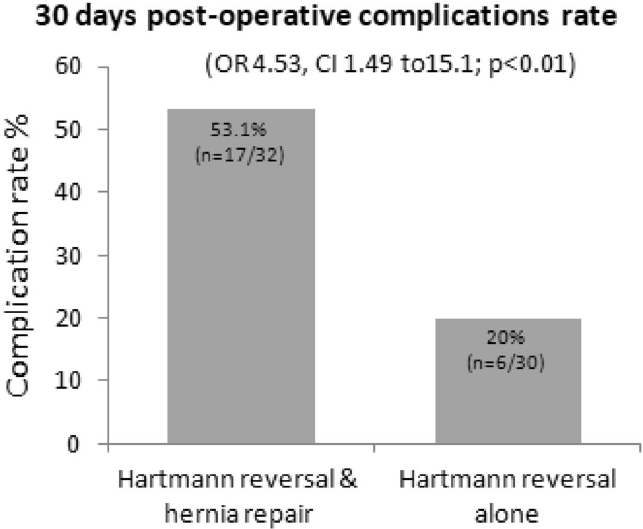
Figure 1. Thirty days post-operative overall complication rate following synchronous Hartmann reversal and hernia repair compared to Hartmann reversal alone (without hernia